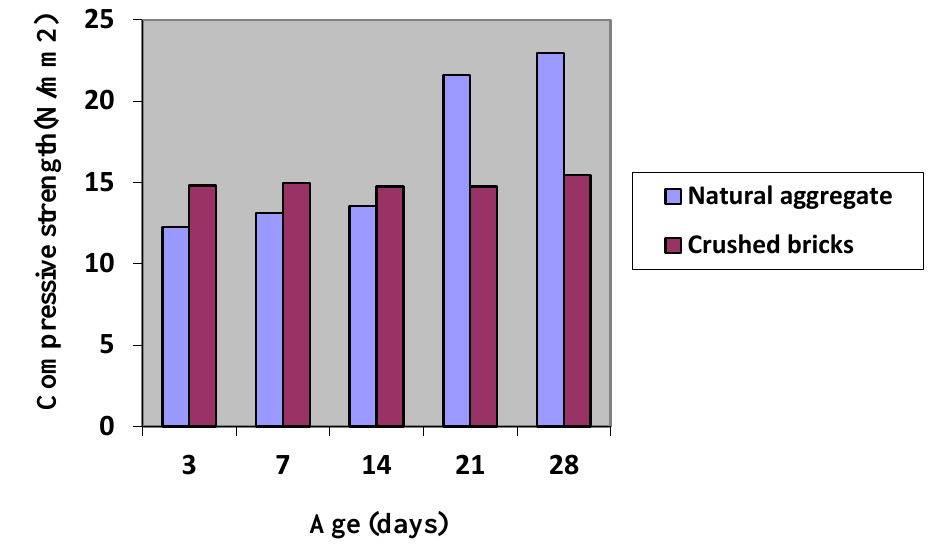
Fig. 3. Compressive Strength of concrete versus